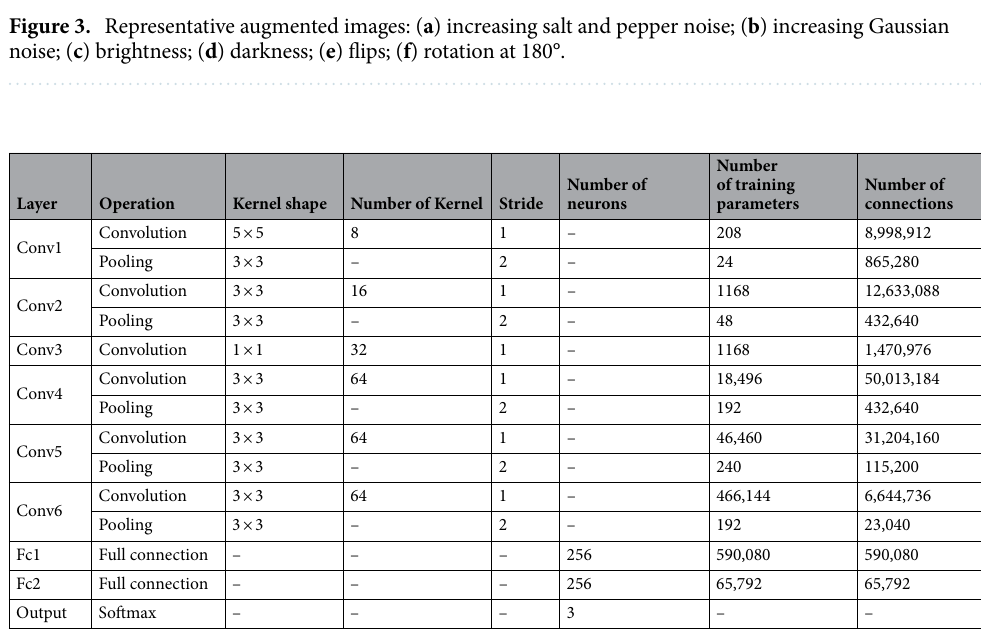
Table 1. Detailed configurations and properties of the proposed